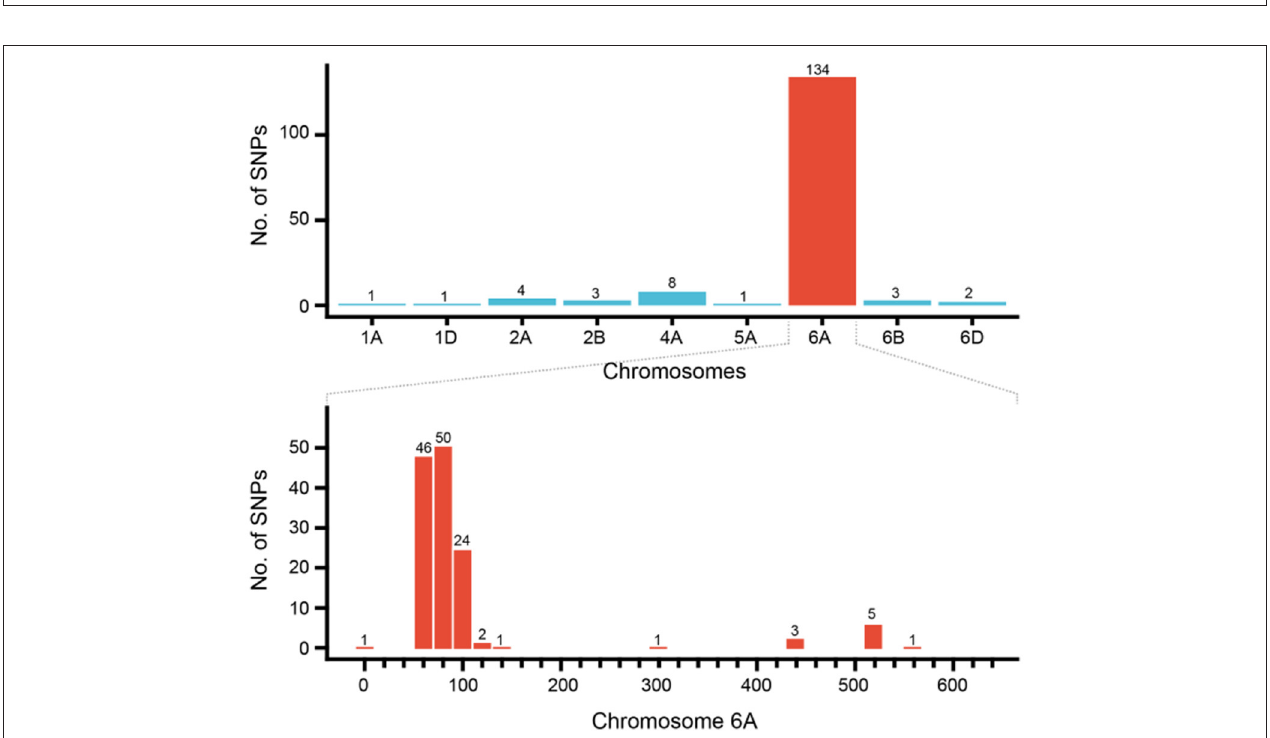
FIGURE 5 | Distribution of SNPs specific to Thinopyrum ponticum in SN0293-2.